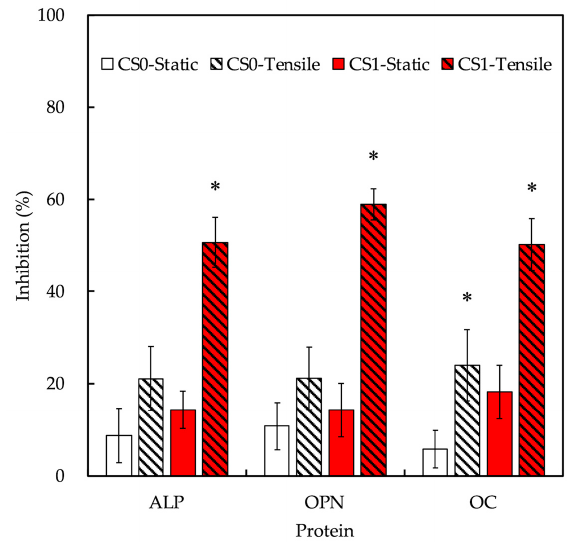
Figure 11. YAP inhibitors regulate the expression of three osteogenic-related proteins (ALP, OPN, and OC) in hPDLs-laden auxetic scaffolds with and without tension stimulation for 3 days. Data presented as mean ± SEM, n = 6 for each group. A p -value of < 0.05 was considered as a significant difference according to the calculation of Scheffe’s multiple comparison test. * represents significant differences when compared to static.